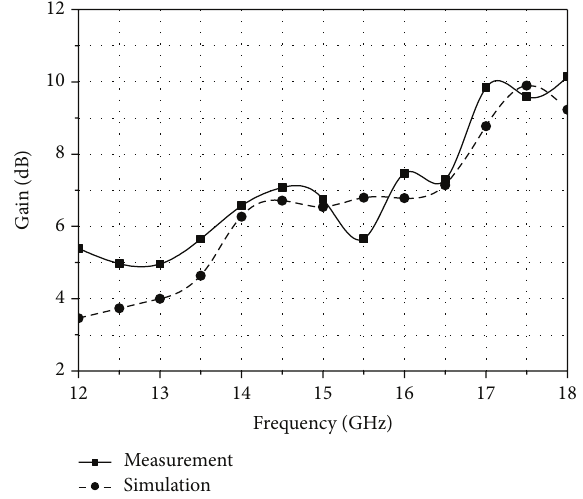
Figure 7: Measured and simulated gain of the center embedded